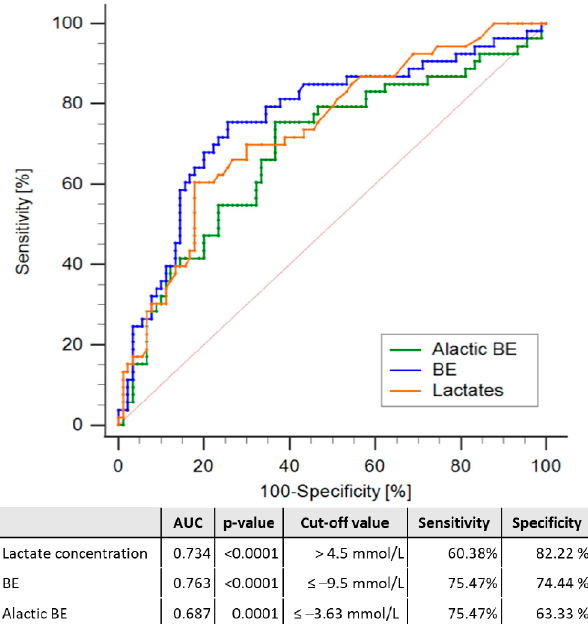
Figure 1. Results of the Receiver Operator Curve characteristics analysis for the prediction of 28-day mortality in shock patients hospitalised in intensive care by aBE (green line), BE (blue line), and lactate concentration (orange line). Median values of areas under the curve (AUC), optimal cut-offs, specificity and sensitivity of BE, lactic concentration, and aBE are shown underneath the graph.